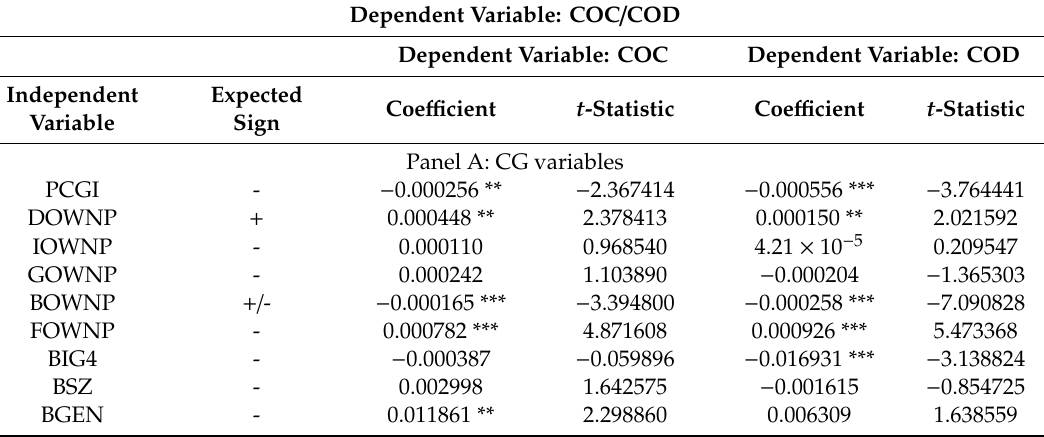
Table 5. Results based on cost of